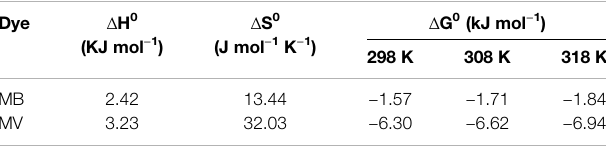
TABLE 5| Thermodynamic parameters for the adsorption ofMB and MVonto the PFPCS at pH (cid:2) 8. The initial dye concentration is 1,500 mg L − 1 and the contact time is 60